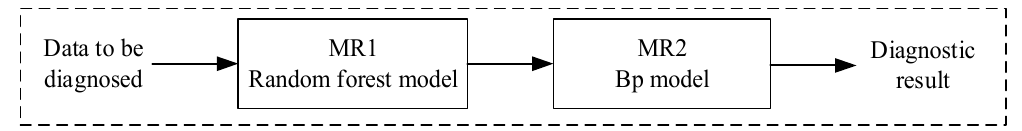
Figure 12. The diagnosis process of SF6 electrical equipment.